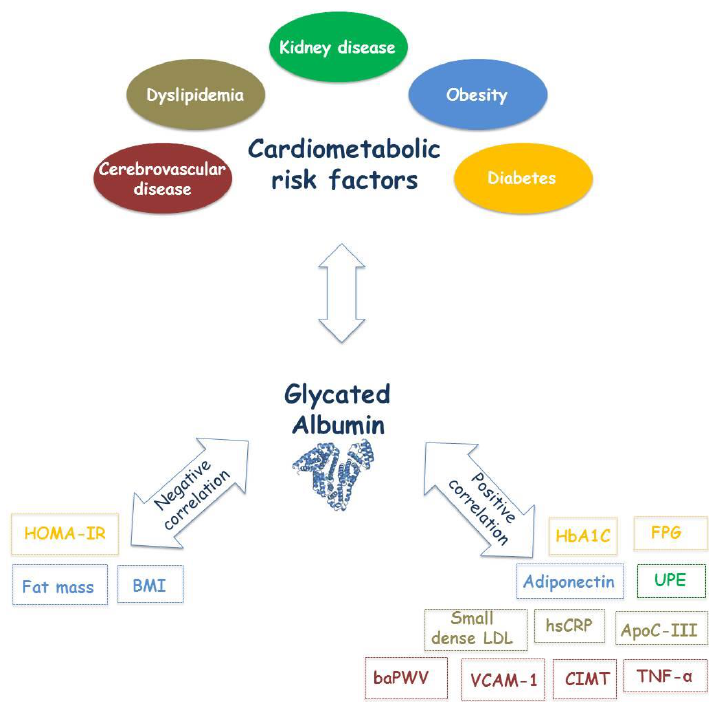
Figure 2. Schematic diagram of GA correlations with metabolic and vascular parameters. The cited parameters are divided into two groups based on their negative or positive correlation with GA and are reported in the same color as the risk factor to which they refer. (baPWV: brachial-ankle Pulse Wave Velocity; BMI: Body Mass Index; CIMT: Carotid Intima-Media Thickness; FPG: Fasting Plasma Glucose; GA: Glycated Albumin; HbA1C: Hemoglobin A1c; hsCRP: high sensitivity C Reactive Protein; LDL-C: Low-Density Lipoprotein Cholesterol; TNF- α : Tumor Necrosis Factors- α ; UPE: Urinary Protein Excretion; VCAM-1: Vascular Cell Adhesion Molecule-1; HOMA-IR: homeostatic model assessment-insulin resistance; ApoC-III: apolipoprotein C-III).